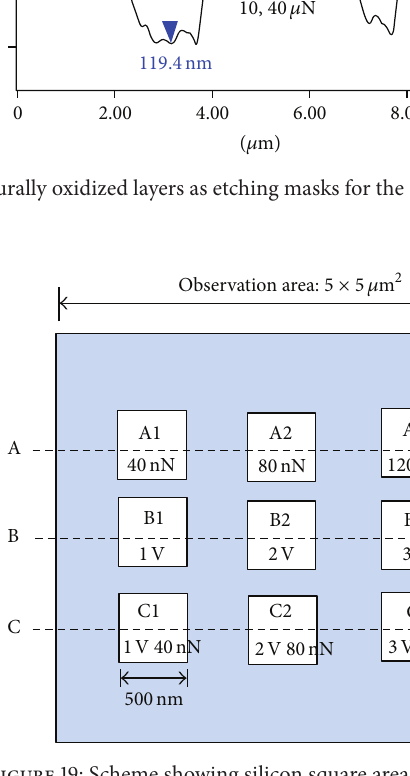
Figure 19: Scheme showing silicon square areas processed through (A-A 1 ) mechanical, (B-B 1 ) electrical, and (C-C 1 ) electromechanical methods at different loads and